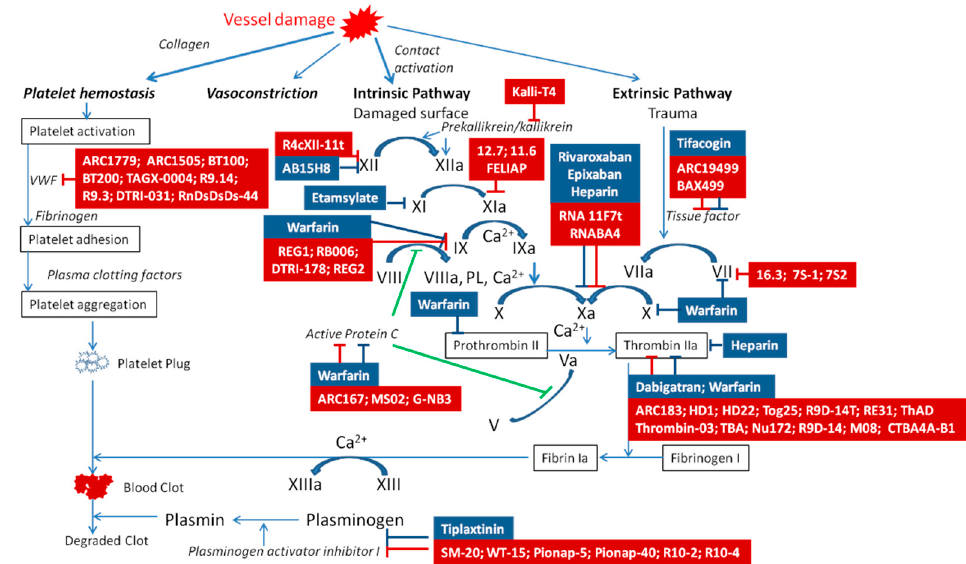
Figure 1. Targets for anticoagulant aptamers and drugs. The hemostasis system consists of primary (platelet) and secondary (coagulation) cascades. Coagulation hemostasis consists of intrinsic and extrinsic pathways, which are combined into a common pathway, the end product of which is insoluble fibrin. The hemostasis system is a cascade of reactions that sequentially activate coagulation factors, and its control allows regulating hemostasis. The schematic representation shows the key regulatory links, the activity of which can be inhibited by standard pharmaceuticals (shown in blue) or aptamers (shown in red). vWF—von Willebrand factor, FL—phospholipids.